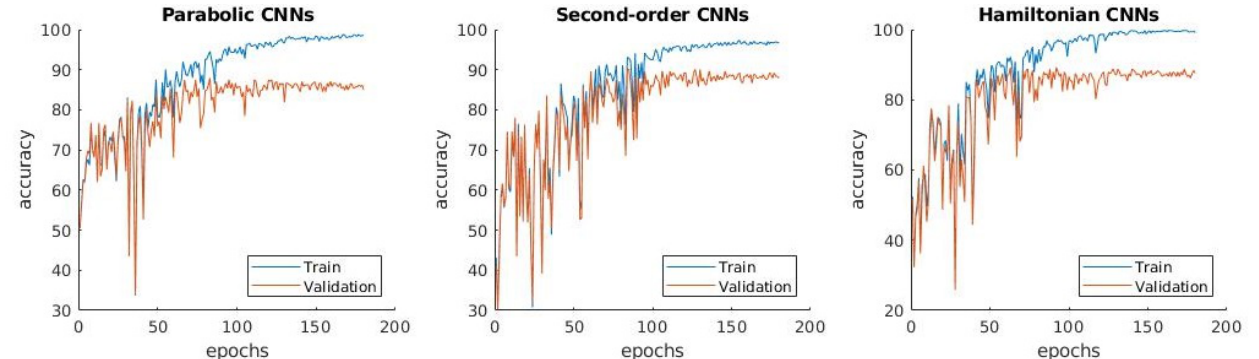
Figure 4. Exp 2 : Accuracy on the downsampled COVID-19 dataset (train: 924, validation: 232